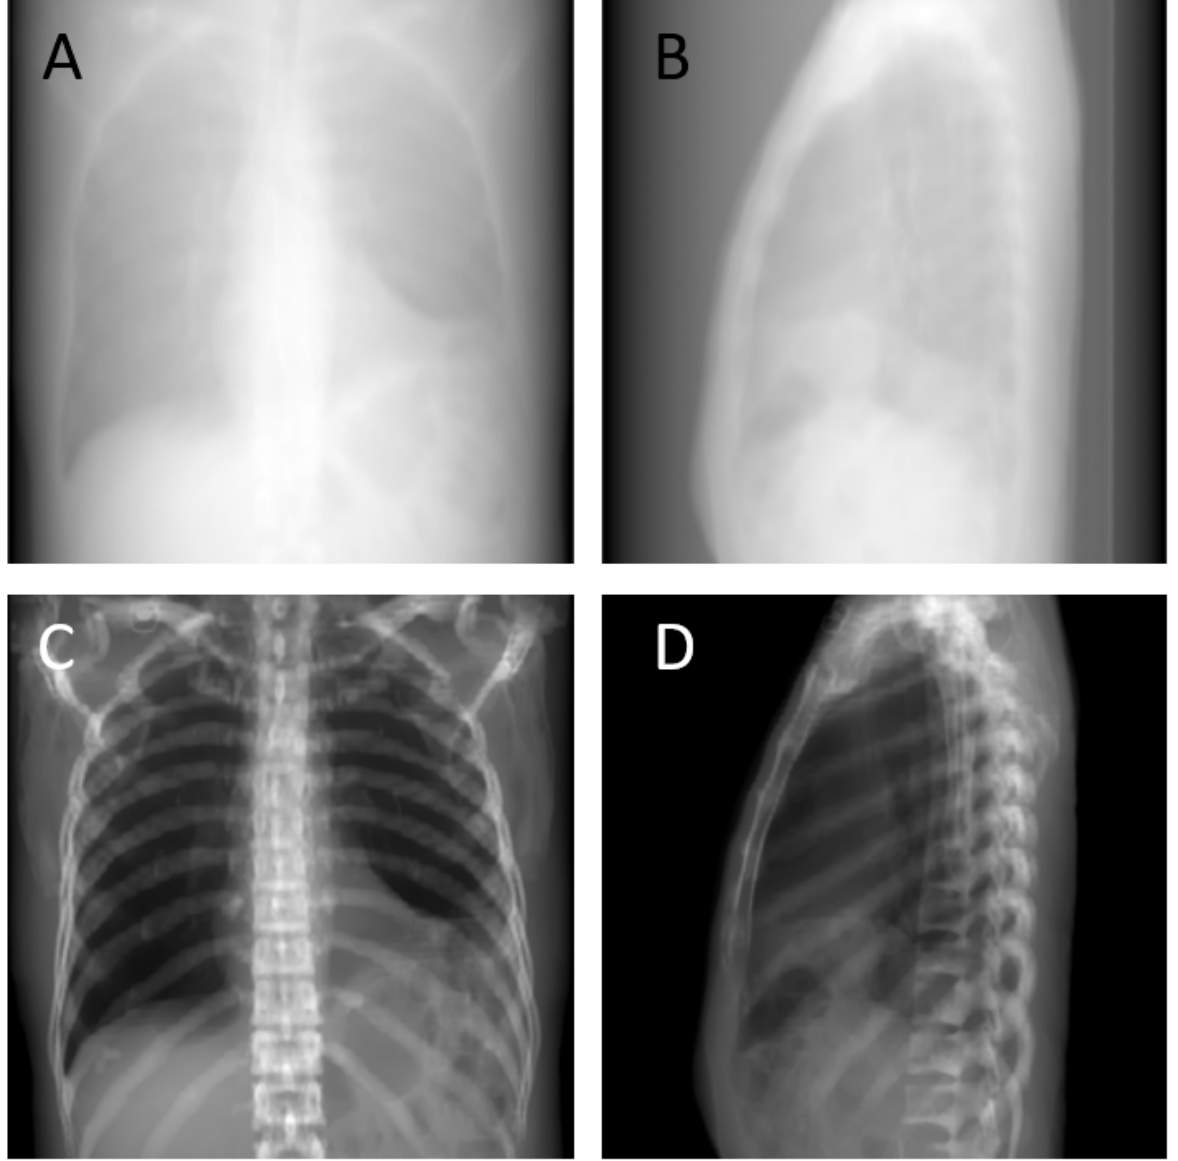
Figure 1. ( A ) Original simulated X-ray of AP view ( B ) Original simulated X-ray of Lat view ( C ) Enhanced bone signal simulated X-ray of AP view ( D ) Enhanced bone signal simulated X-ray of Lat view.